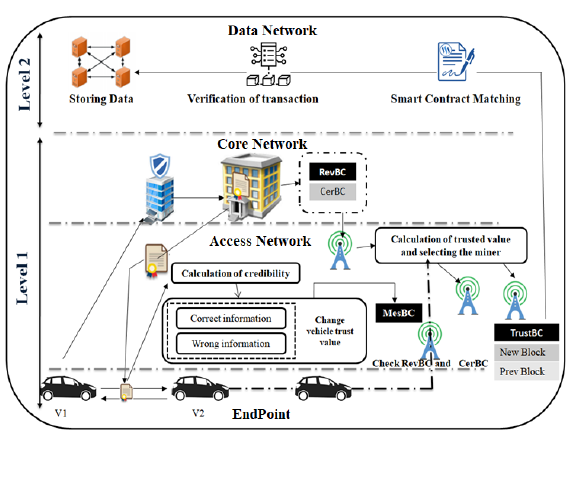
FIGURE 4. PROPOSED BLOCKCHAIN ARCHITECTURE IN 5G-V2X